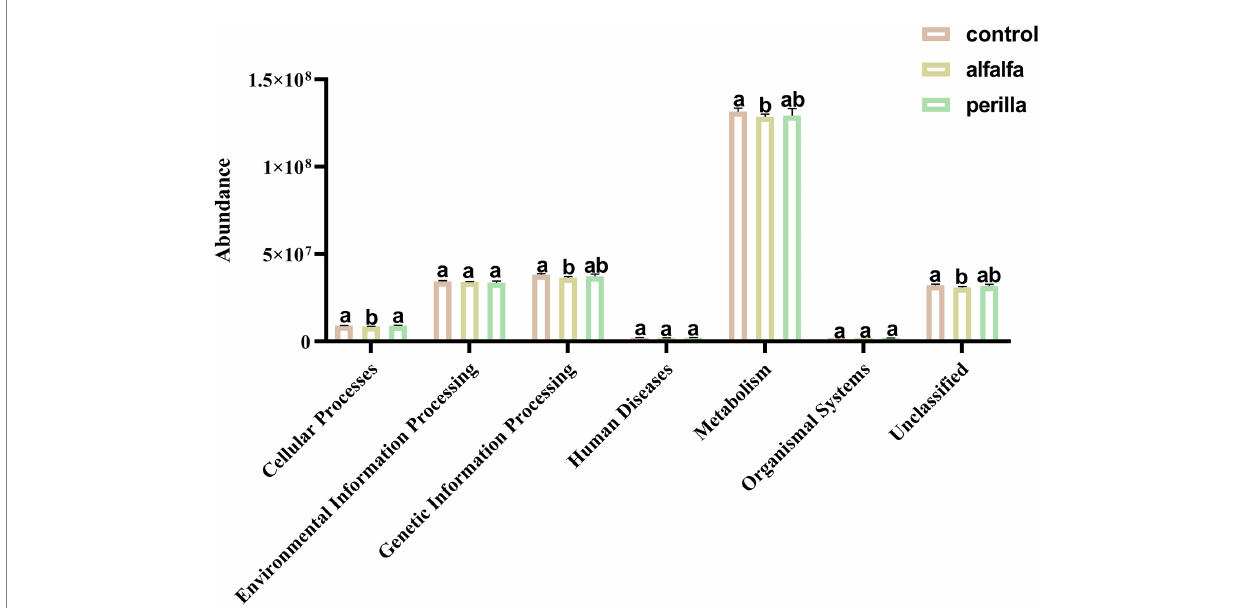
FIGURE 8 Soil bacterial function prediction in different treatments (Hierarchy level 1). Different letters indicate a significant difference at the p < 0.05 level. Control, no treatment; Alfalfa, alfalfa cultivation; Perilla, perilla